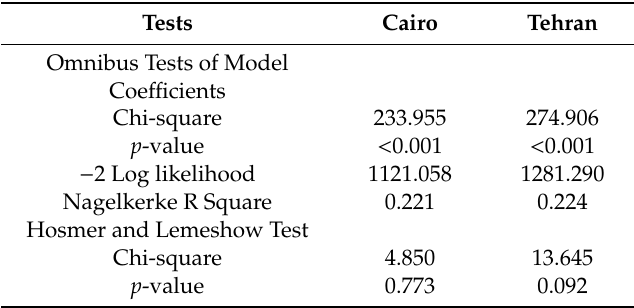
Table 2. The results of the Omnibus test and the Hosmer and Lemeshow test for biking.